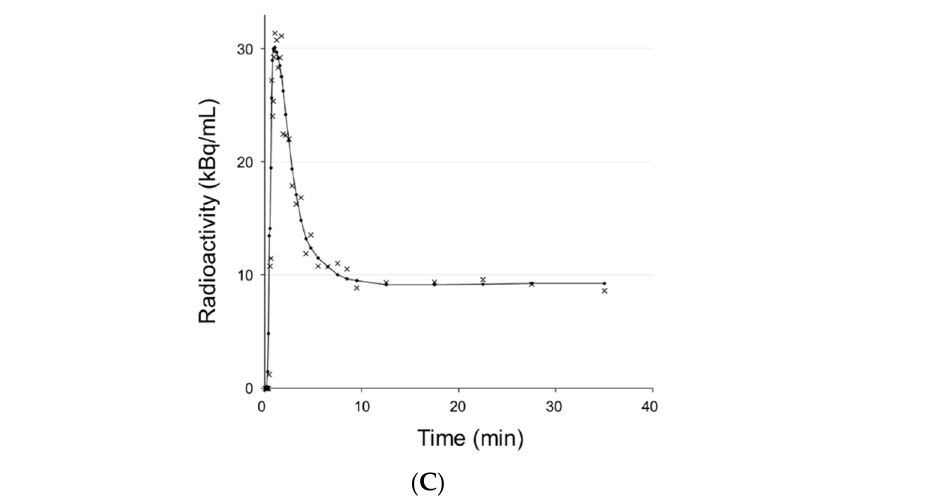
Figure 4. ( A ) The whole arterial blood radioactivity concentration was estimated by the IDIF method (circle), which was then corrected to the real input function (x and solid line) by the undissociated rate of 64 Cu-ATSM (insert) [11]. ( B ) The Patlak plot calculated from the corrected IDIF (C p ) and cerebral tissue counts (C t ) shows good linearity in the later phase of 64 Cu-ATSM PET scan (slope: 0.032, r 2 = 0.994). The slope represents K in value. ( C ) Representative NLS fitting based on two-tissue compartment three-parameter model. The fitting provides an estimate of k 3 .